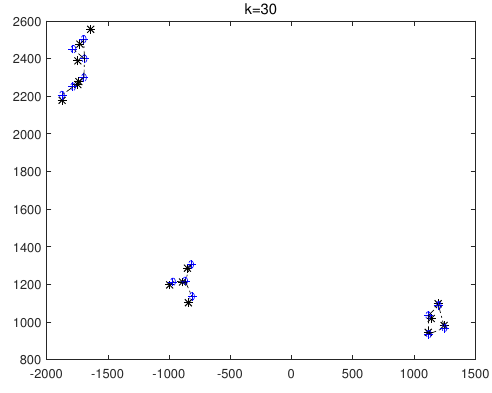
Figure 10. The structure estimation of group targets at k = 20.